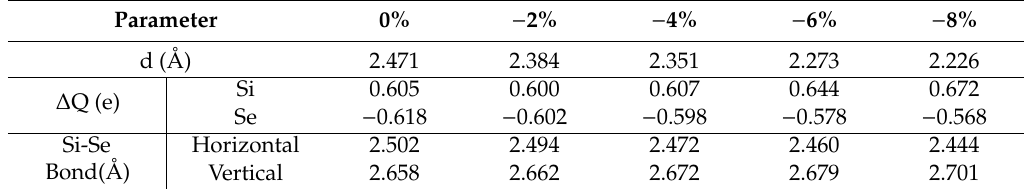
Table 3. Mulliken charge transfer ( ∆ Q) of Si atom closest to the NH 3 molecule and connected Se atom, the nearest distance (d) and the length of Si-Se bond of NH 3 gas molecule adsorbed on SiSe monolayer after biaxial stress from 0% to − 8%.